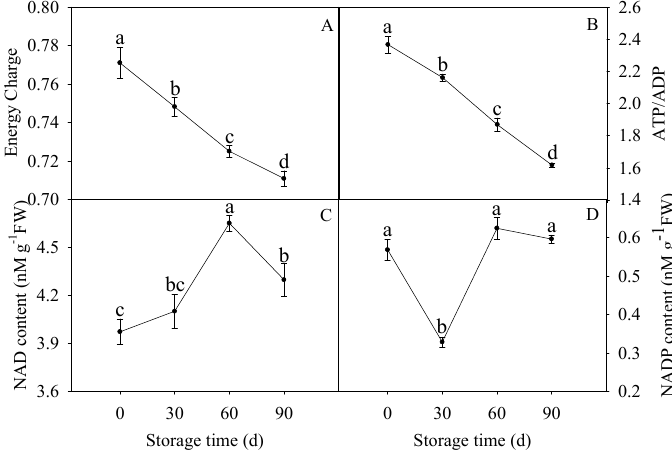
Figure 1. Changes in energy charge (EC) ( A ), ATP / ADP ( B ), nicotinamide adenine dinucleotide (NAD) ( C ), and nicotinamide adenine dinucleotide phosphate (NADP) content ( D ) in postharvest pumelos during storage at 25 °C. Each data point was shown as the mean ± standard error (SE). Different letters indicated significant difference ( p < 0.05).